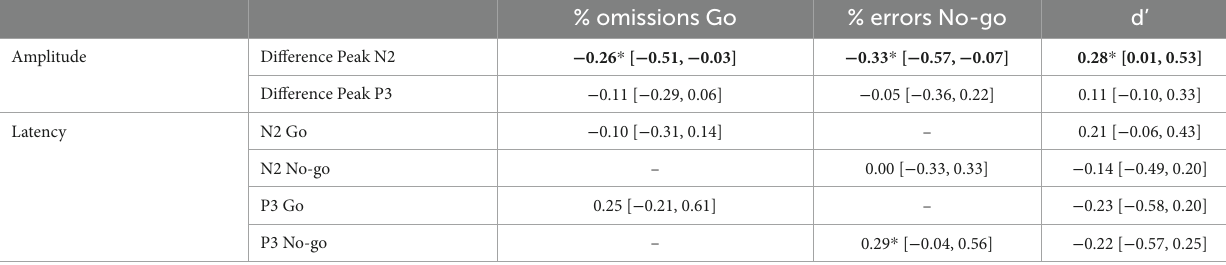
* p < 0.05; 95% confidence intervals after bootstrapping with 1,000 samples in square brackets. Significant correlations according to both p -value and CI interpretation are highlighted in bold. N2 difference peak amplitude = Go minus No-go condition. P3 difference peak amplitude = No-go minus Go condition. Only ERP latencies and behavioral measures for the same experimental condition were